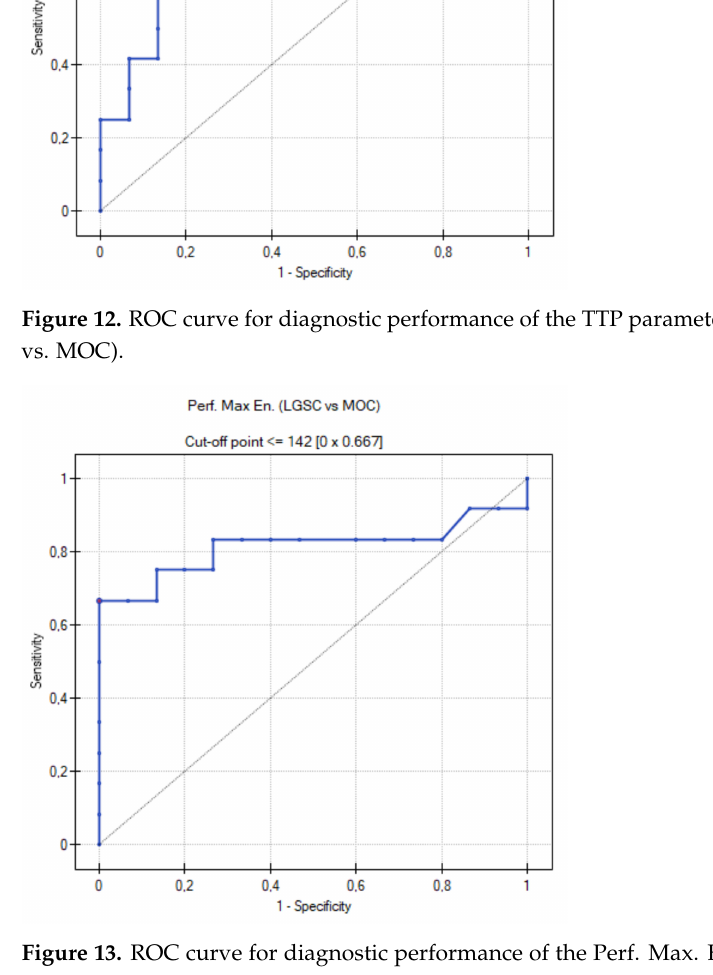
Figure 13. ROC curve for diagnostic performance of the Perf. Max. En. parameter in detection of EOC (LGSC vs.